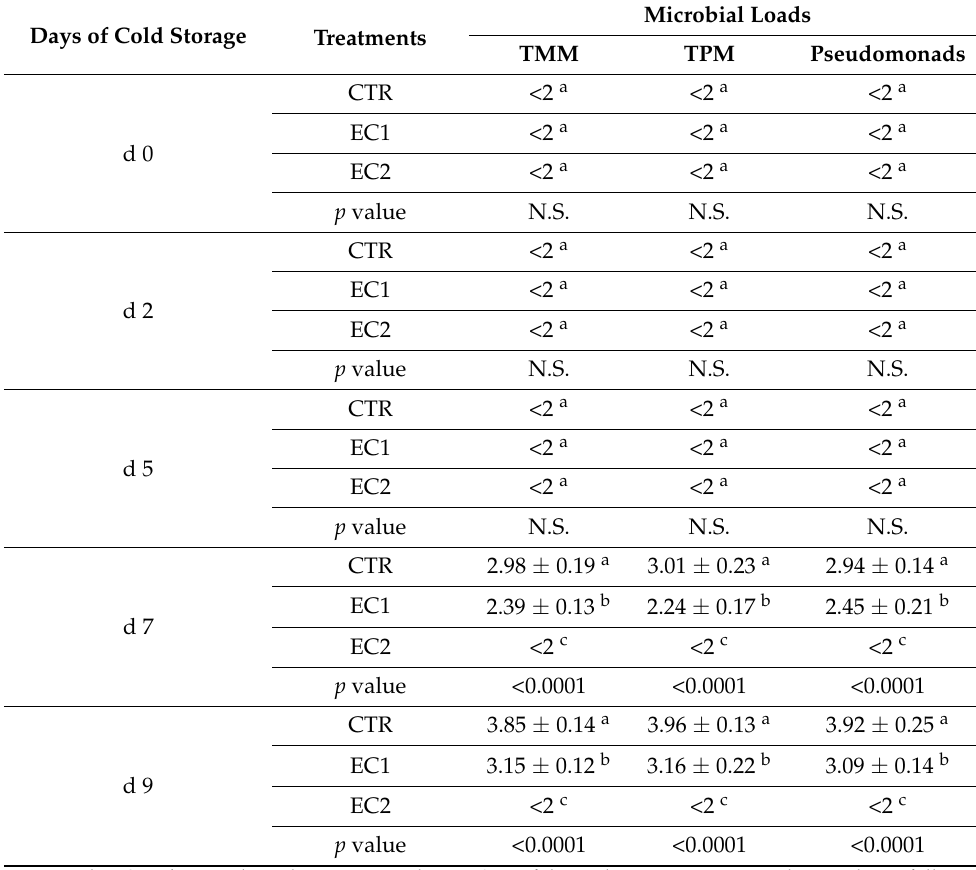
Table 1. Microbial loads of mango cube samples. Days of Cold